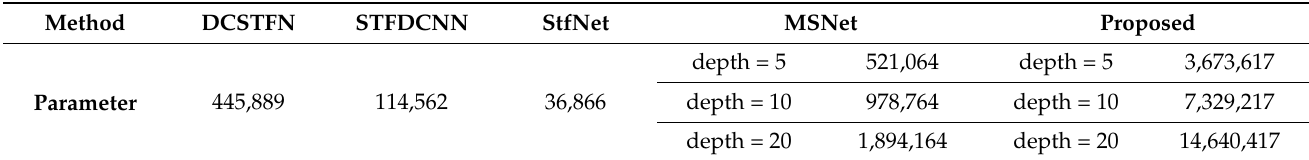
Table 7. Number of parameters for different deep learning